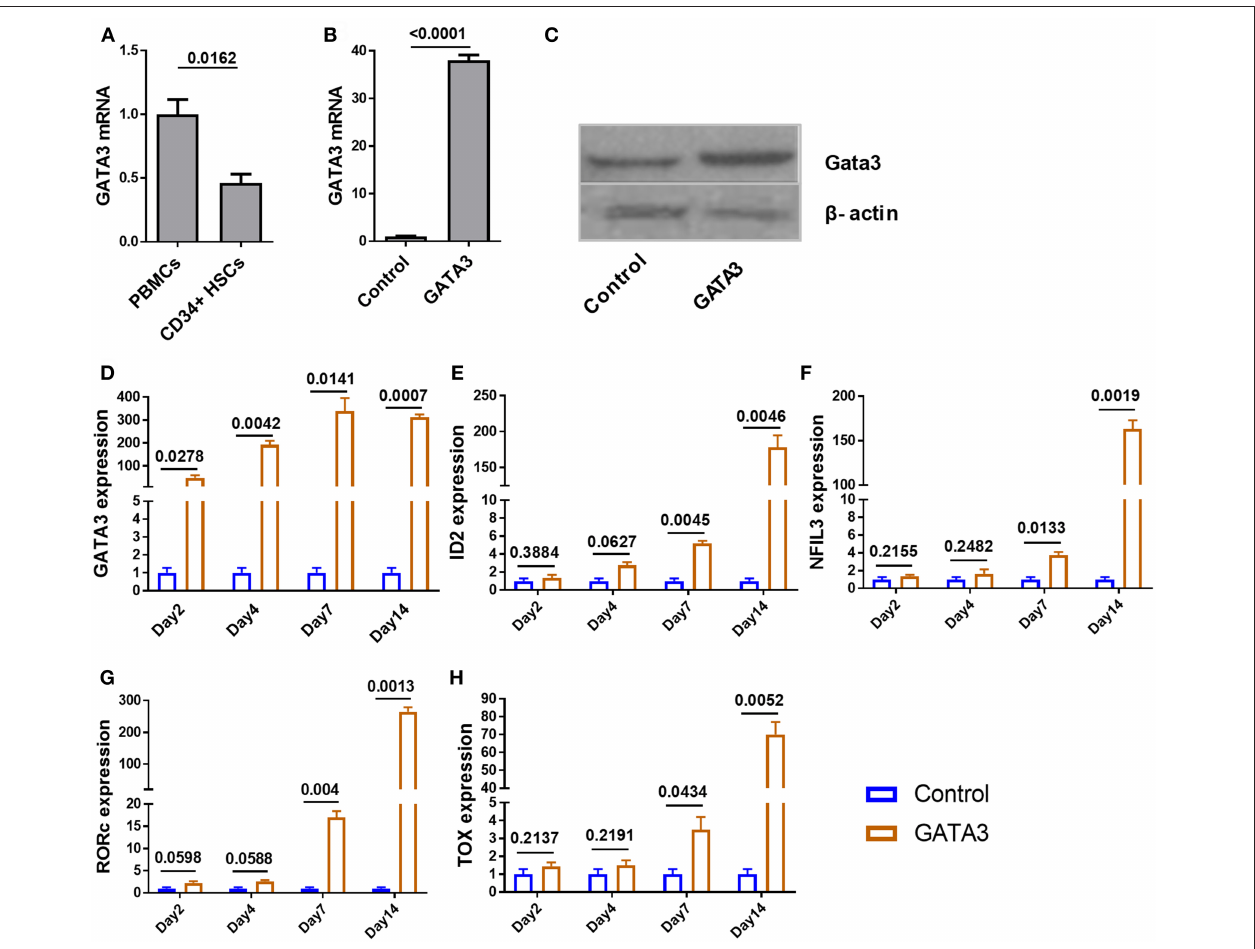
FIGURE 2 | Ectopic expression of GATA3 in CD34 + HSCs has no immediate influence on other ILC related transcription factors. Five-day expanded UCB CD34 + HSCs were transfected with either GATA3 mRNA (GATA3) or scrambled mRNA (Control) and RNAs were extracted at various time points to perform qPCR. To assess GATA3 protein, cells were also lysed 48h post transfection. (A) The quantitative expression of GATA3 mRNA in UCB CD34 + HSCs is shown relative to its expression in UCB mononuclear cells after normalizing to the expression of GAPDH ( n = 4/group). (B) The quantitative expression of GATA3 mRNA in GATA3 transfected cells is shown relative to control cells after normalizing to the expression of GAPDH ( n = 5/group). (C) Western blot of GATA3 protein from the cell lysates at 48h following GATA3 or control mRNA transfection. (D,H) The quantitative expression of genes at each time point in GATA3 transfected cells is shown relative to its expression in control cells after normalizing to the expression of GAPDH ( n = 3/group). (A,B,D–H) Data are shown as means ± SD, p -values are depicted and paired two-tailed t